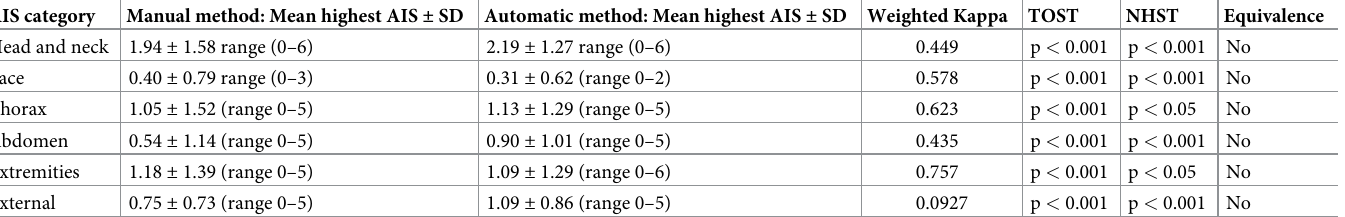
Table 4. Results of the inter-rater reliability and equivalence testing between manually and automatically AIS scores of each body region. AIS